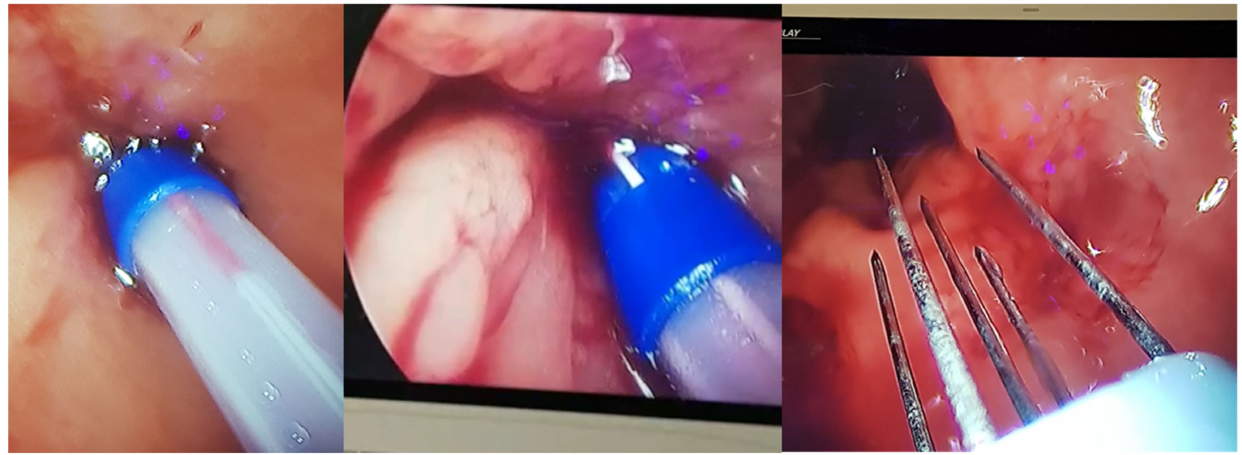
Figure 2. ECT with a trans-anal laparoscopic approach and a SILS port on the primary rectal tumor with semi-annular morphology and extension from hours to 2 to 5 using an expandable divergent electrode with 10 degrees of divergence, a length of 20 cm, and a 5 mm